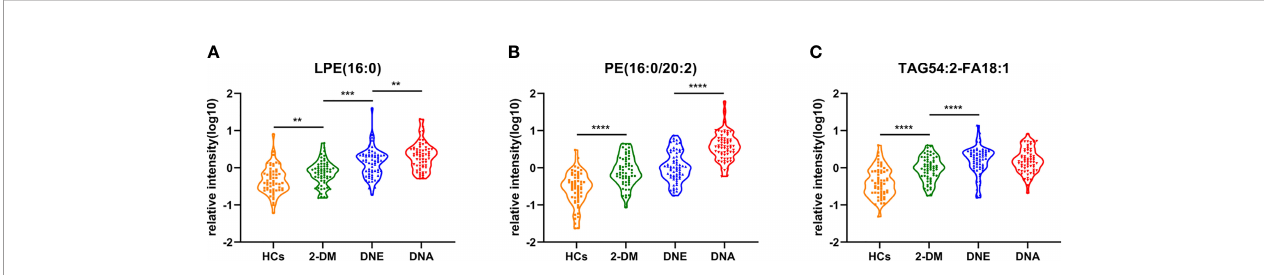
FIGURE 6 | Serum relative intensity of LPE(16:0) (A) , PE(16:0/20:2) (B) , and TAG54:2-FA18:1 (C) in the HCs (orange), 2-DM (green), DNE (blue) and DNA (red). **P < 0.01, ***P < 0.001, and ****P < 0.0001.